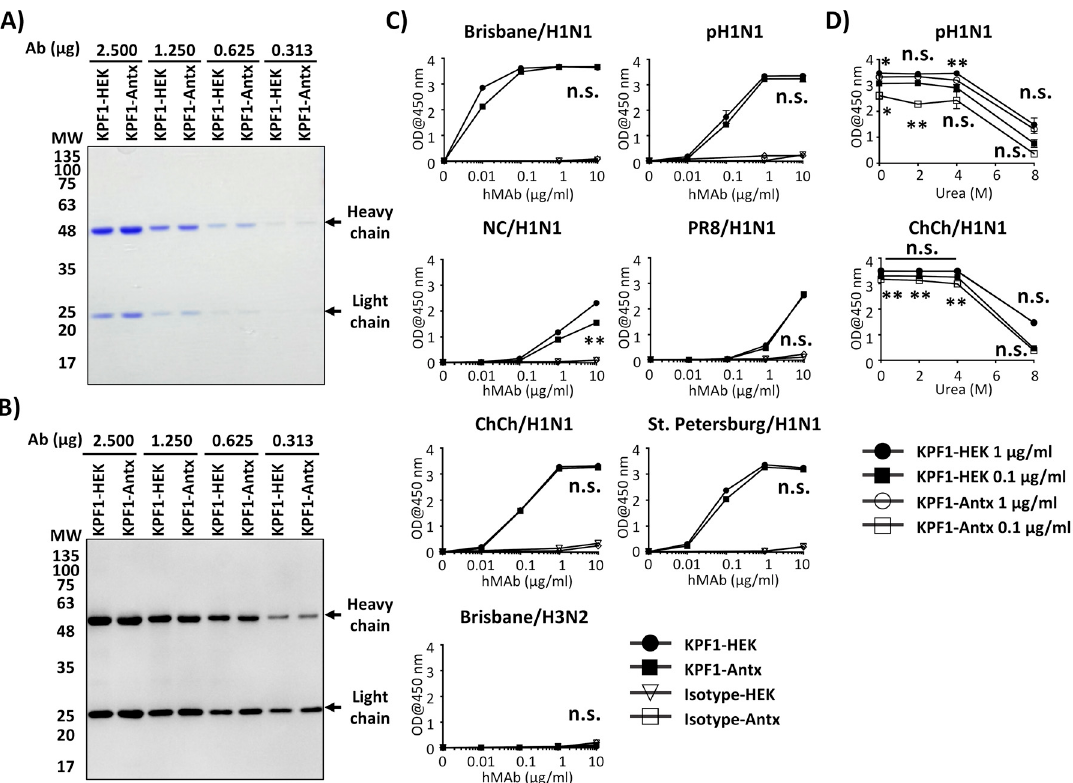
Figure 2. In vitro characterization of KPF1-Antx hMAb. ( A,B ) Purity and mobility of the KPF1-HEK and KPF1-Antx hMAbs: Equal amount of KPF1 hMAbs (2.500, 1.250, 0.625, and 0.313 µ g) generated from either HEK293T cells (KPF1-HEK) or tobacco plants (KPF1-Antx) were separated by SDS-PAGE and evaluated by Coomassie blue staining (A) or Western blot using an anti-human IgG HRP-conjugated Ab (B). ( C ) Recombinant HA binding of KPF1-HEK and the KPF1-Antx hMAbs: Binding to 1 µ g / mL of indicated HA proteins was determined for serially diluted hMAbs by ELISA. n.s.: no significance. ( D ) Avidity: Binding of hMAbs in the presence of increasing concentrations of urea was determined by ELISA. The statistical analysis between KPF1-HEK and KPF1-Antx (markers above the lines; between 1 µ g / mL of KPF1-HEK and KPF1-Antx, marker below the lines: between 0.1 µ g / mL of KPF1-HEK, and KPF1-Antx), * p < 0.05, ** p < 0.01, or no significance (n.s.).